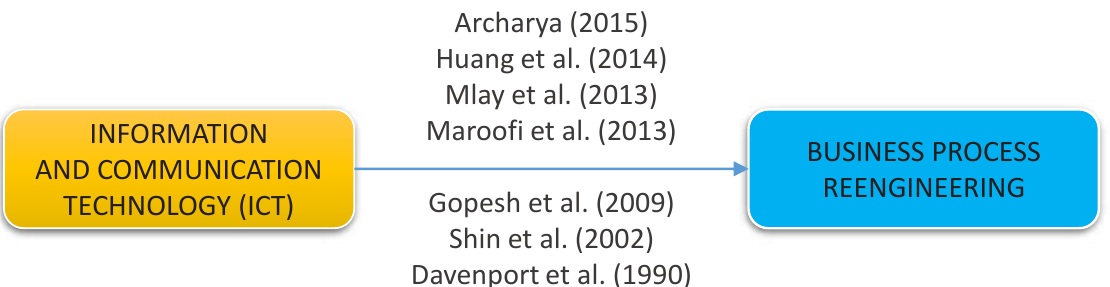
Figure 7. The information and communication technology relationship toward business